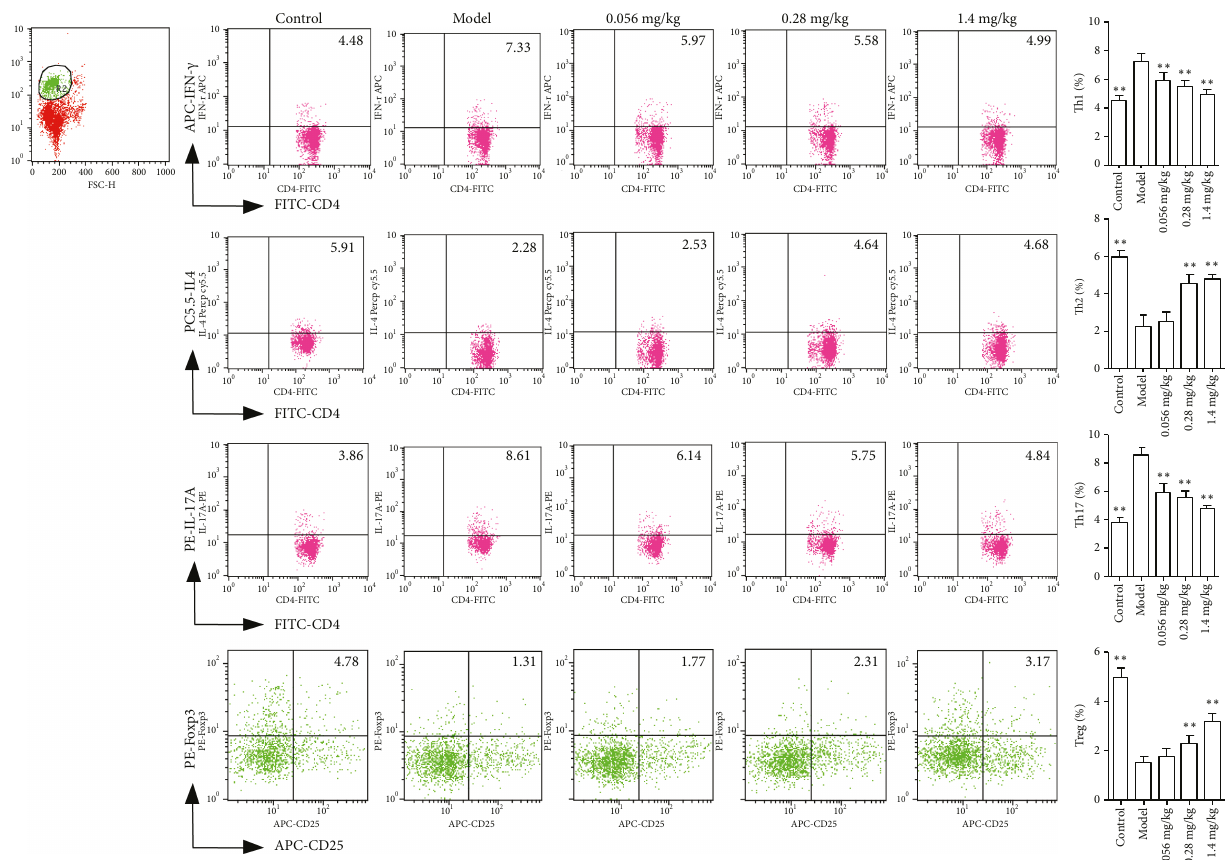
Figure 6: Koumine suppresses the di ff erentiation of Th1 and Th17 cells while enhances Th2 and Treg cells. Cells were analyzed for the percentages of Th1, Th2, Th17, and Treg cells in the CD4 subsets by fl ow cytometry. ∗∗ p < 0 01 versus the model